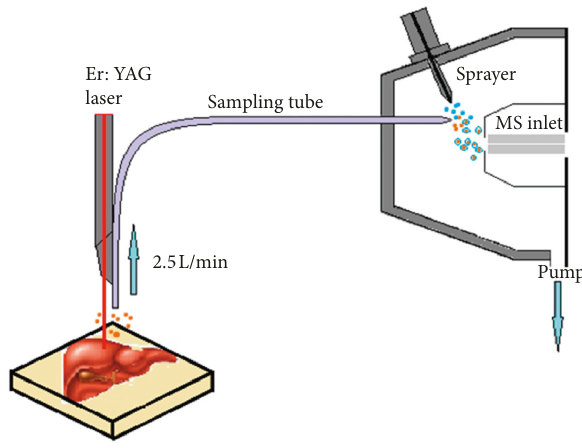
Figure 1: Schematic diagram of LAESI-MS for